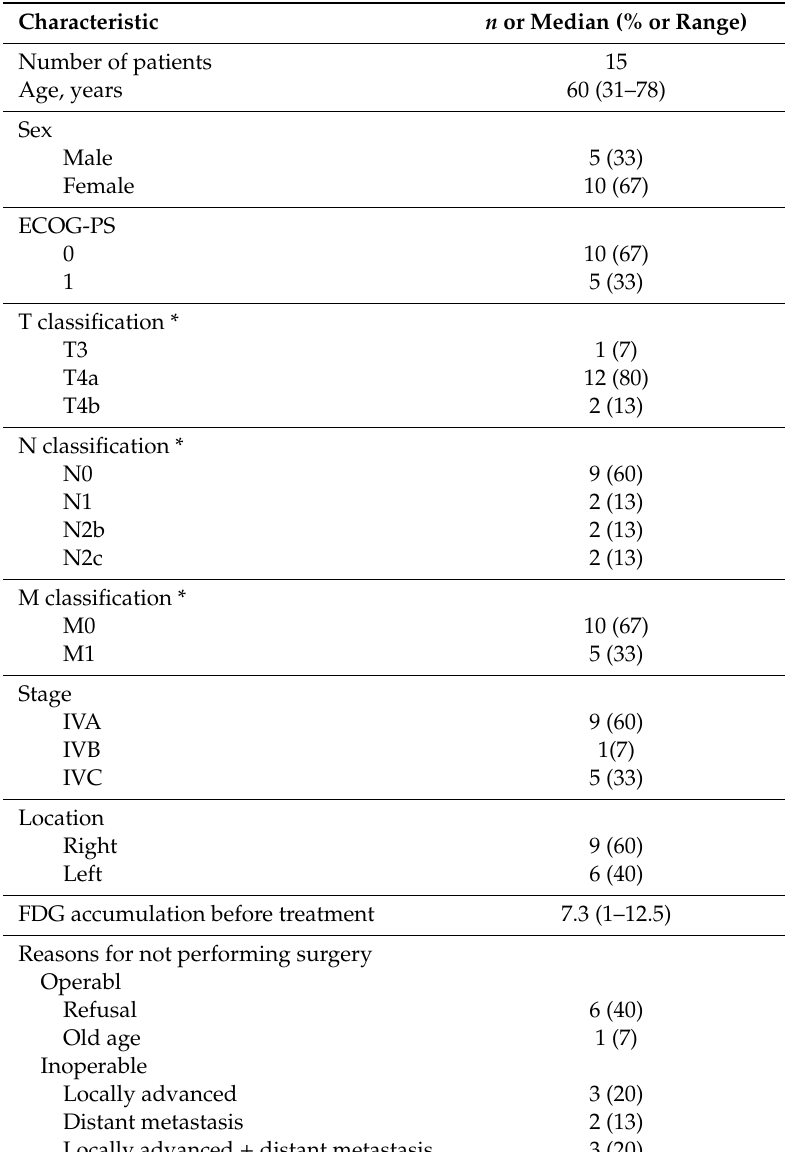
Table 1. Patient